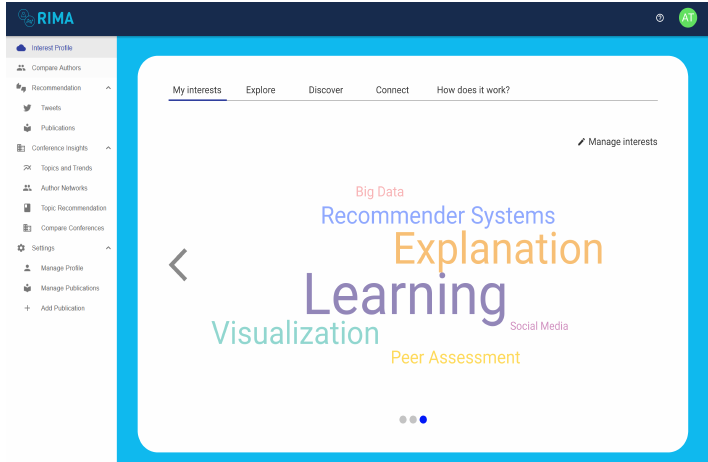
Figure 15. Interest as word cloud.